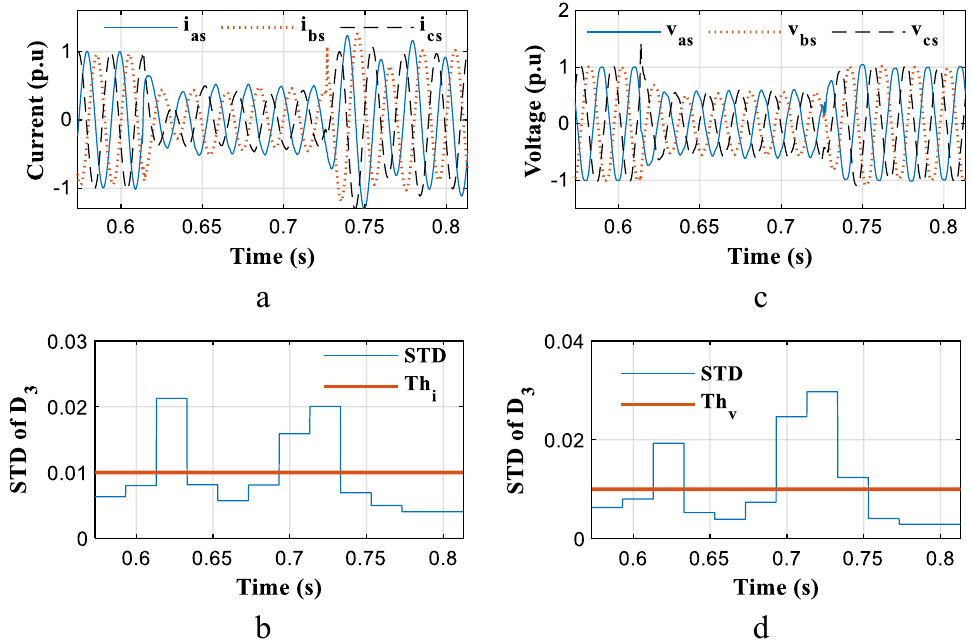
Fig. 17 Performance evaluation of proposed criteria using practical results for a voltage sag 20%, a Three-phase stator current signals, b The current criterion, c Three-phase stator voltage signals, d The voltage criterion